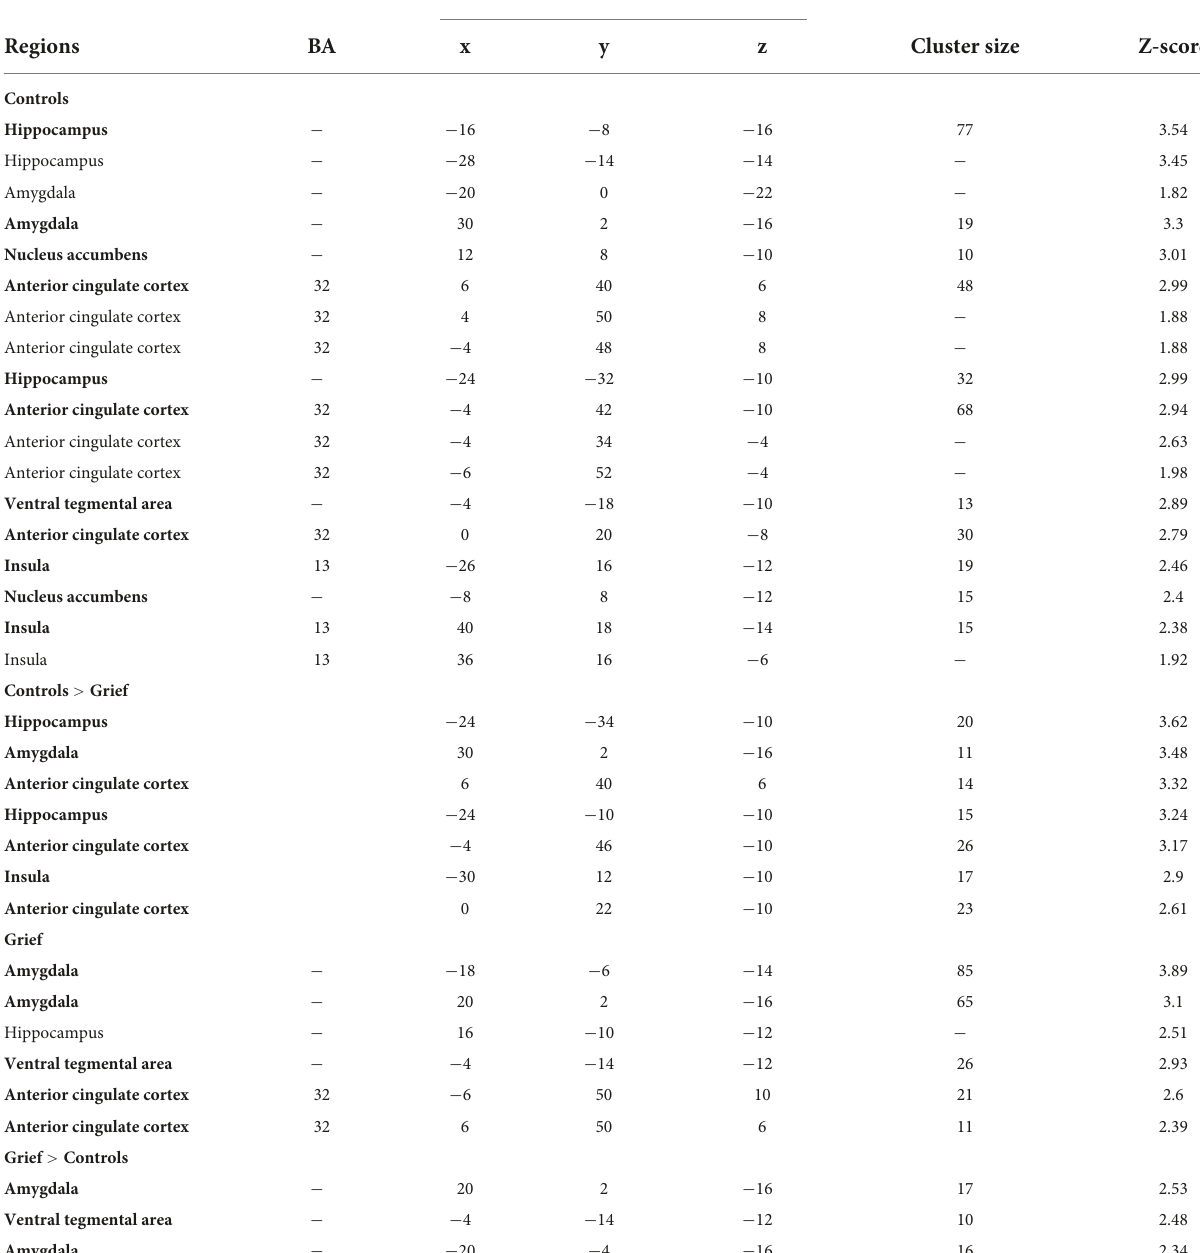
TABLE 3 Resting-state paraventricular thalamic nucleus (PVT)-area functional connectivity results ( p < 0.05 uncorrected). MNI